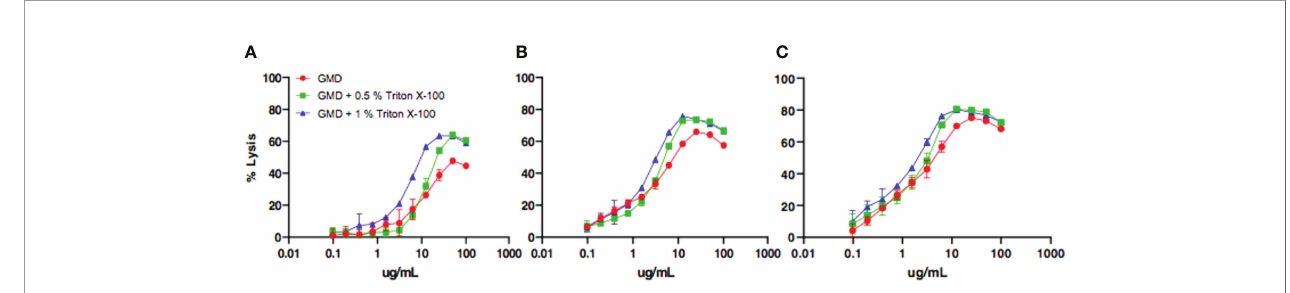
FIGURE 1 | Optimization of in vitro assay assessing Gmd digestion of M. luteus cell wall. The indicated concentration ( m g/ml) of puri fi ed recombinant S. aureus Gmd was incubated with heat-killed M. luteus in the presence of the indicated amount of Triton X-100 at 37°C for 5 min (A) , 60 min (B) , or 120 min (C) , and the percentage of lysis of M. luteus cell wall extract was determined by optical density as described in Materials and Methods . Note that the peak percentage of lysis (~80%) was achieved with a concentration of 10 m g/ml Gmd, 0.5% Triton X-100, and incubation time of 60